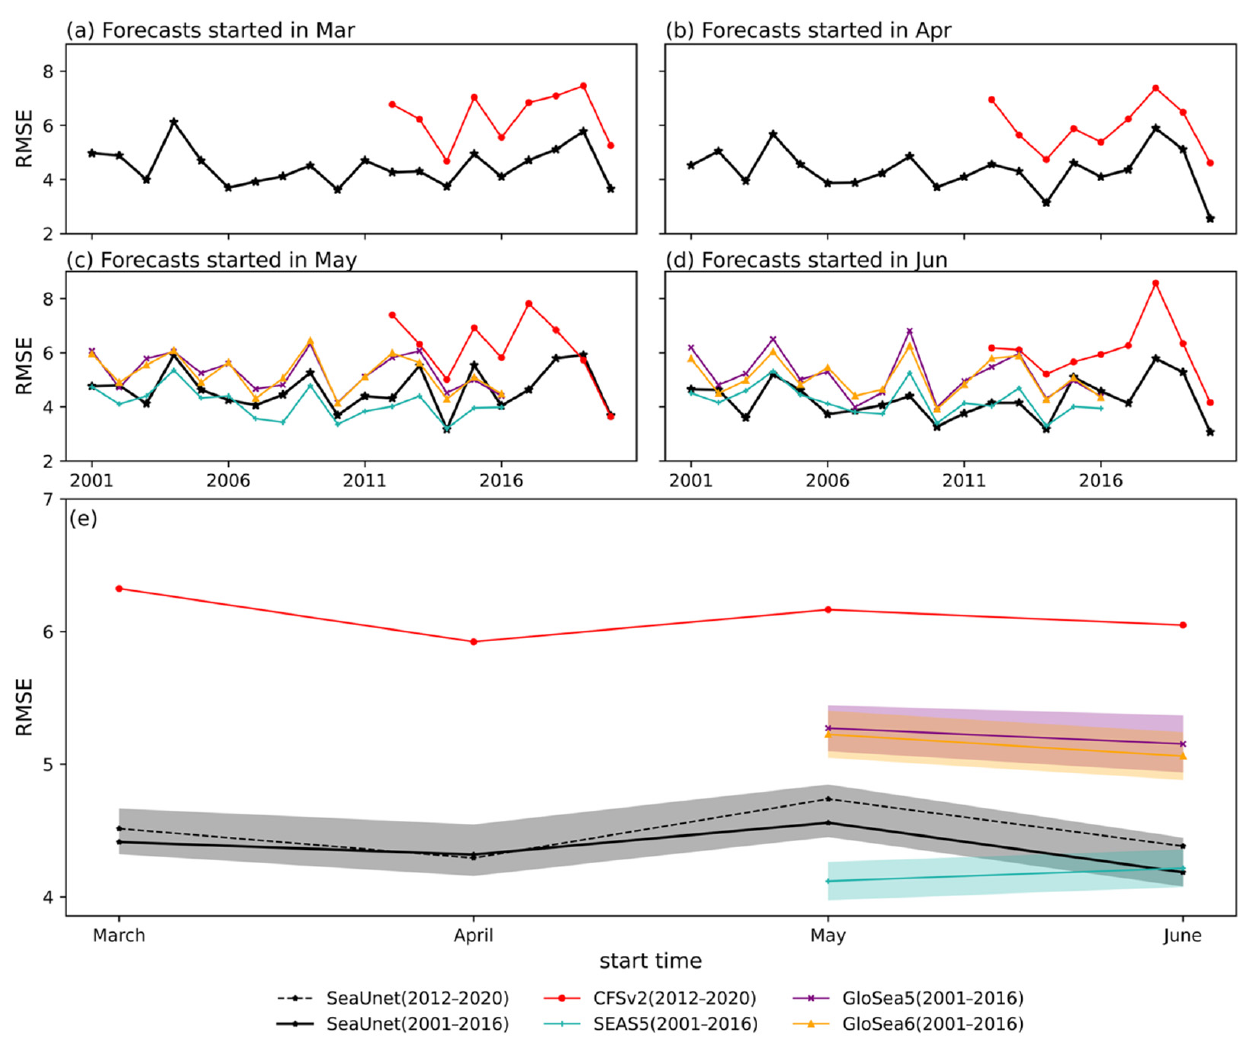
Figure 3. Area-averaged root-mean-square error (RMSE) between predicted TC track density results. Annual RMSE of the predicted TC track density of SeaUnet, SEAS5, Glosea5, and Glosea6 ensemble mean with respect to the observation in different starting months (i.e., ( a ) start in March; ( b ) start in April; ( c ) start in May; and ( d ) start in June), with SeaUnet for the time range from 2001 to 2020, CFSv2 for the time range from 2012 to 2020, SEAS5, Glosea5, and Glosea6 for the time range from 2001 to 2016. ( e ) RMSE of each model changing with starting time. The solid line represents the average error of the ensemble mean of each model in the selected year, and the shading represents the 25% variance of the ensemble members. To ensure the rationality of comparison, the time range of the solid line for SeaUnet is from 2001 to 2016, and the time range of the dotted line is from 2012 to 2020; the time range for CFSv2 is from 2012 to 2020; and the time range for SEAS5, Glosea5, and Glosea6 is from 2001 to 2016.